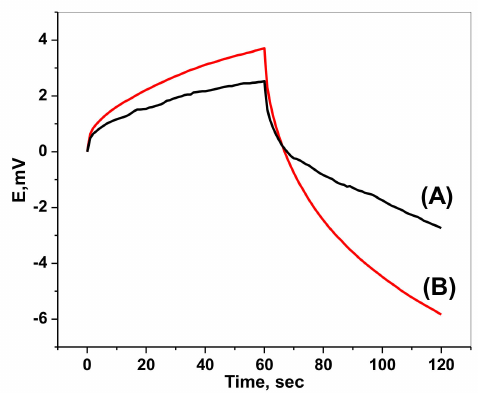
Figure 4. Chronopotentiograms of paper based sensor for chromium (VI) sensors ( A ) with PANI as a solid contact and ( B ) without using PANI, applied current: + 1 nA for 60 s and − 1 nA for 60